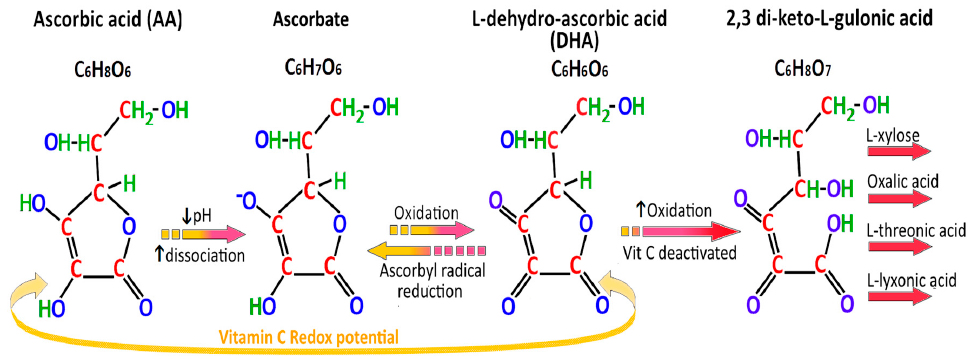
Figure 4. The redox potential of ascorbate. At the normal acidic gastric pH, secreted gastric ascorbic acid dissociates into ascorbate. Ascorbate can act as an antioxidant by reversible oxidation to DHA, and then be regenerated by glutathione-dependent DHA reductase back to ascorbate. DHA can be irreversibly oxidized to 2,3 di-keto-L-gulonic acid and thence excreted in the urine as oxalate.